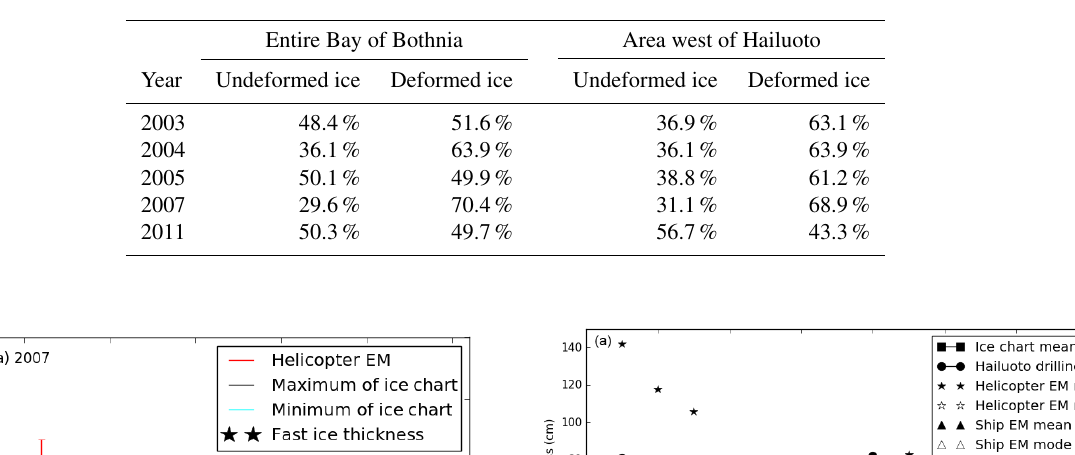
Table 3. The fraction of undeformed and deformed ice in helicopter EM measurements in the entire Bay of Bothnia and in the area west of Hailuoto. The drilling measurement in Hailuoto station in each year approximately on the 1 March has been used as a threshold between undeformed and deformed ice.